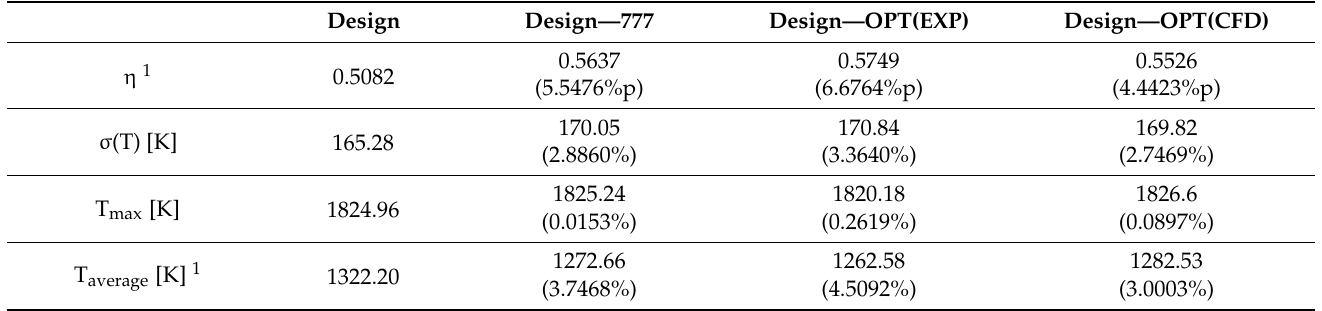
Table 8. Comparison of the cooling performance for the nozzle vane applied to the fan-shaped hole.